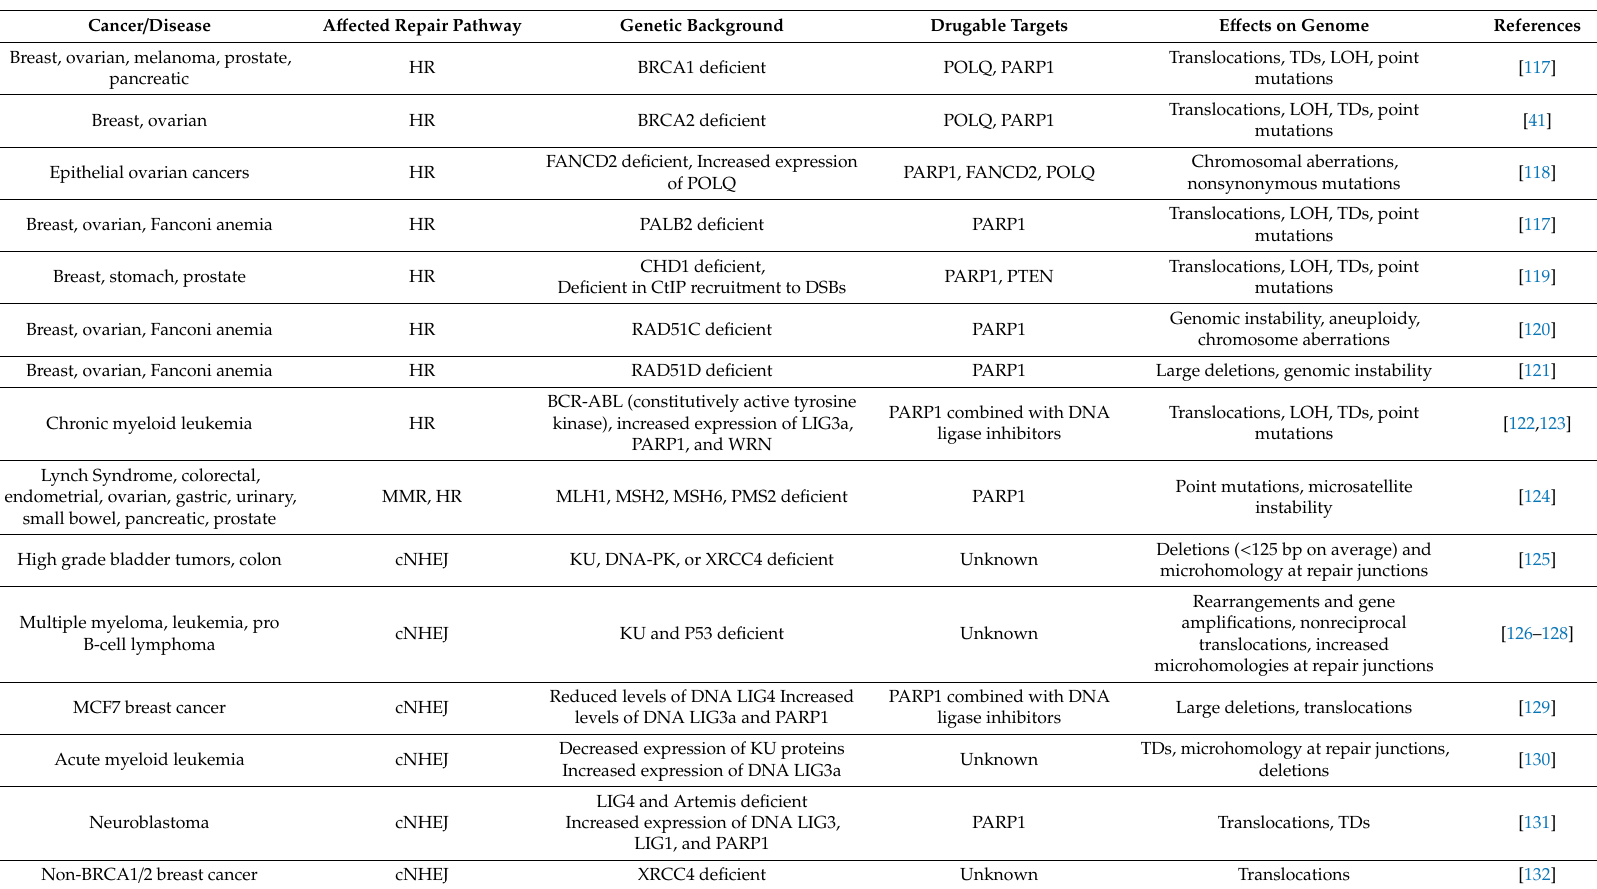
Table 1. Cancers reliant upon error-prone DSB repair. For each type of cancer / disease, the repair pathway that is impaired, genetic background, and the types of genomic mutations observed are listed. The druggable targets column indicates therapeutic approaches that may be used to exploit a synthetic lethal interaction. TD = tandem duplications, LOH = loss of